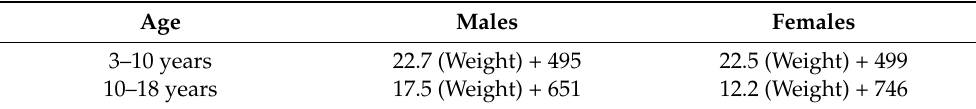
Table 1. Weight-based equation for calculating energy requirements (kcal/day) according to the FAO/WHO/UNO